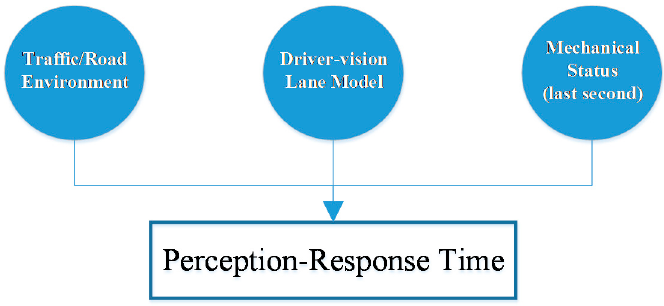
Figure 6. Three parts in perception-response time prediction model. Table 5. Explanation of Parameters Considered in the Prediction Model.